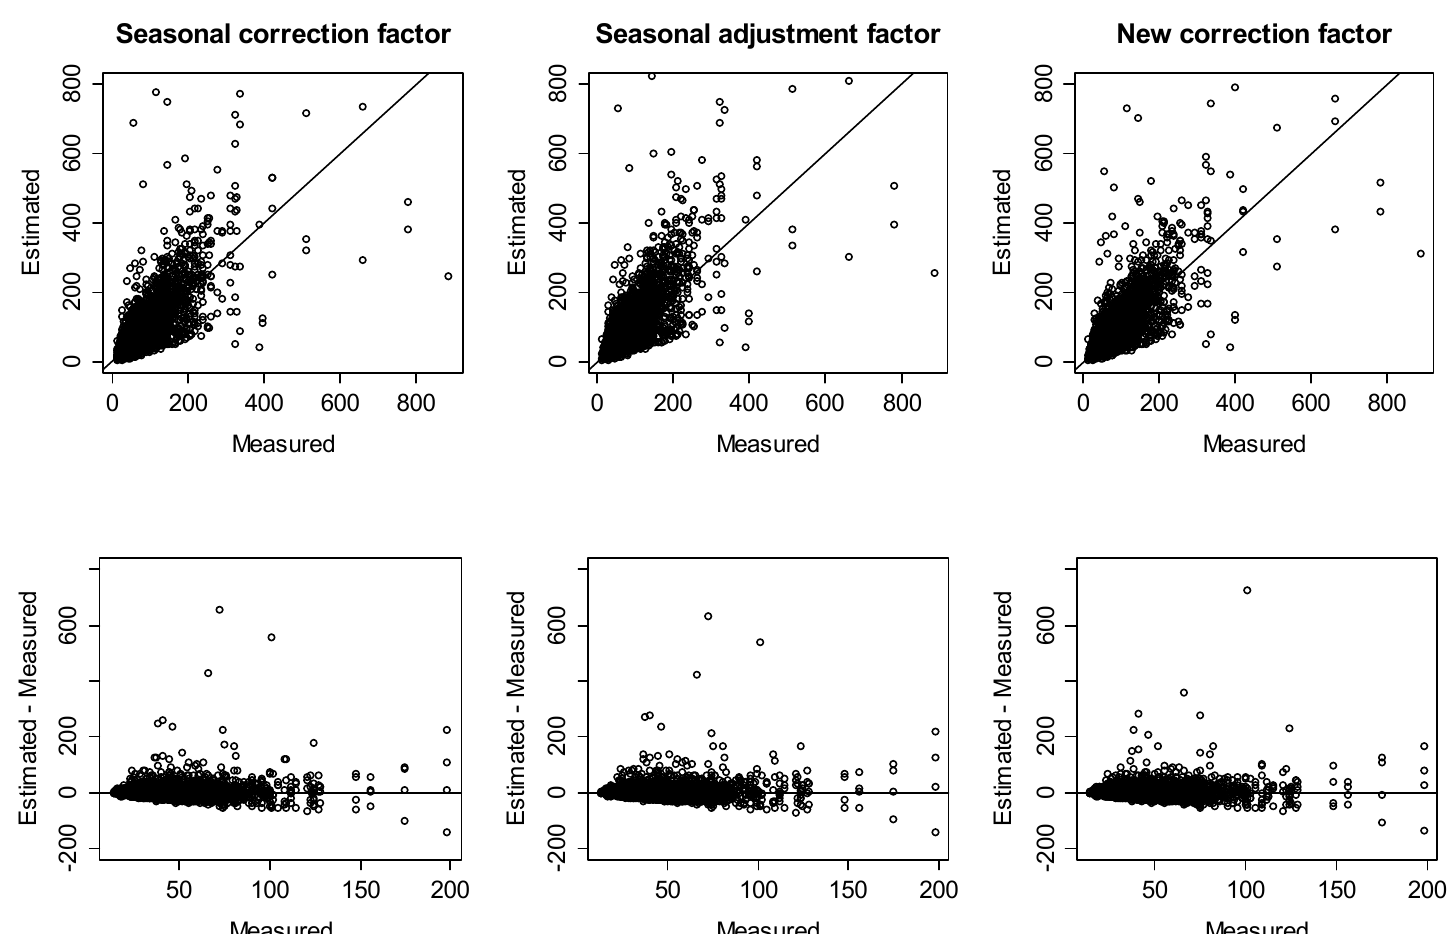
Figure 5. Comparisons of measured and estimated mean annual radon concentrations for other residences.